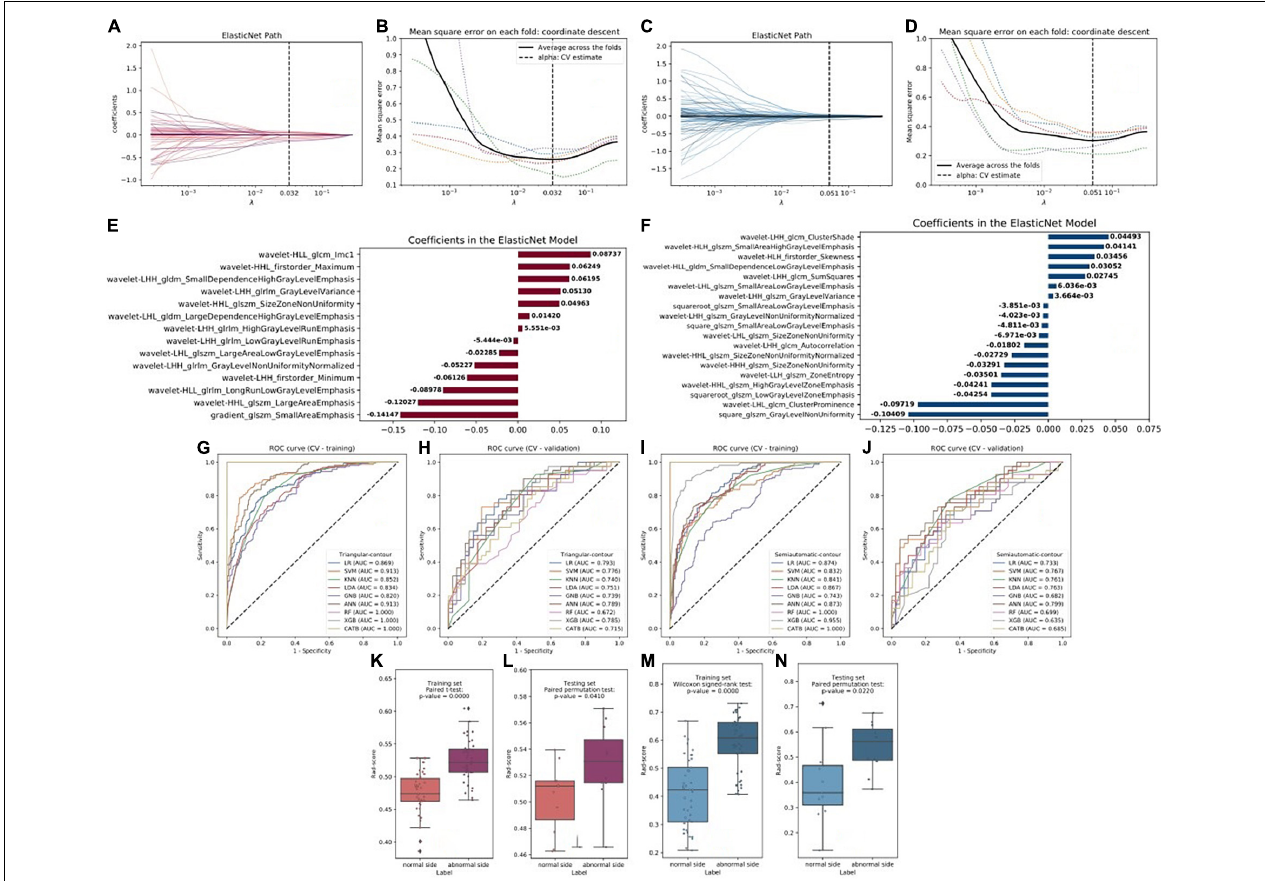
FIGURE 2 | (A,C) Radiomics feature selection and rad-score construction of triangular contour (red, left) and semiautomatic contour (blue, right). The coefficient lambda of the penalty term in elastic net was seen as a hyperparameter and tuned via the fivefold cross-validation (CV) method. The black curve showed the average mean square error (MSE) for each model given lambda. The x-axis indicated the values of lambda. The vertical lines marked the values of the best lambda which were 0.032 and 0.051. (B,D) Radiomics features coefficients reduction-path curves. Finally, 14 non-zero factors for triangle contour and 19 for semiautomatic contour were selected. (E,F) The retained non-zero-coefficient features were plotted on the y-axis and their coefficients in the elastic net were plotted on the x-axis. (G–J) The receiver operating characteristic (ROC) curves of the 9 radiomics machine learning models. (K–N) Paired samples tests showed that there were significant differences in the rad-score which would be used to discriminate the patients into the two